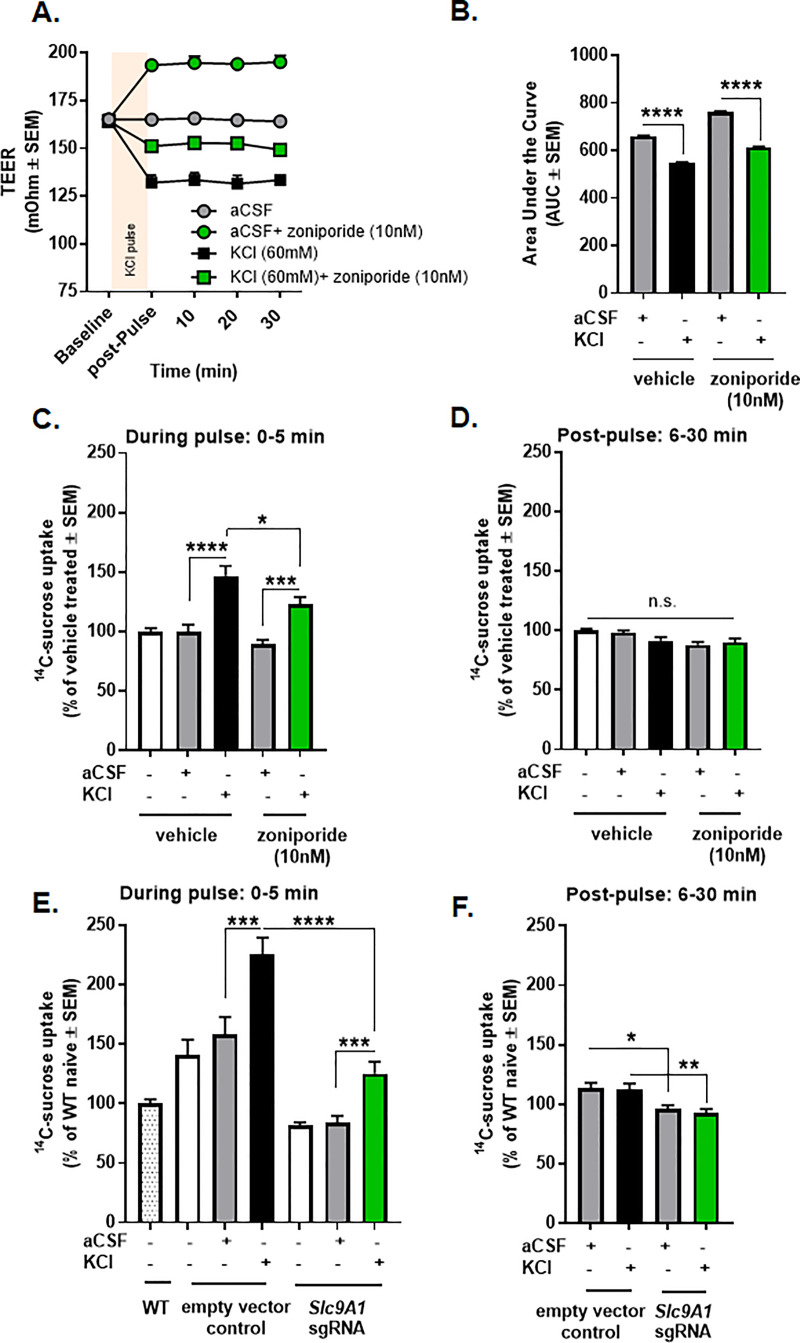
KCl pulse induced temporary paracellular leak in bEnd.3 endothelial cells, which was reduced, but not completely abolished by selective inhibition of NHE1.(A) TEER values after a 5 min pulse of KCl (60 mM) or aCSF with or without pretreatment of zoniporide (10 nM). Values are the mean ± SEM (n = 9). (B) The area under the curve for TEER values. (C)
14C-sucrose uptake during a 5 min KCl or aCSF pulse with or without pretreatment of zoniporide (10 nM). All data represent % of vehicle treated ± SEM (n = 9–11). (D)
14C-sucrose uptake 30 min post-pulse with or without pretreatment of zoniporide (10 nM). All data represent % of vehicle treated ± SEM (n = 9–11). (E)
14C-sucrose uptake during KCl or aCSF pulse after the genetic engineering of NHE1. All data represent % of wild-type naïve ± SEM (n = 9). (F)
14C-sucrose uptake 30 min post-pulse after the genetic engineering of NHE1. All data represent % of wild-type naïve ± SEM (n = 9). * p<0.05, ** p<0.01, *** p<0.001, **** p<0.0001 as assessed by one-way ANOVA. n.s. = non-significant.